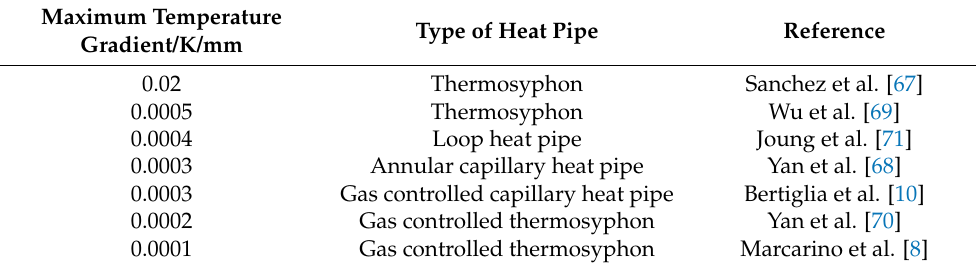
Table 5. Characteristics of heat pipes for isothermal performance of in